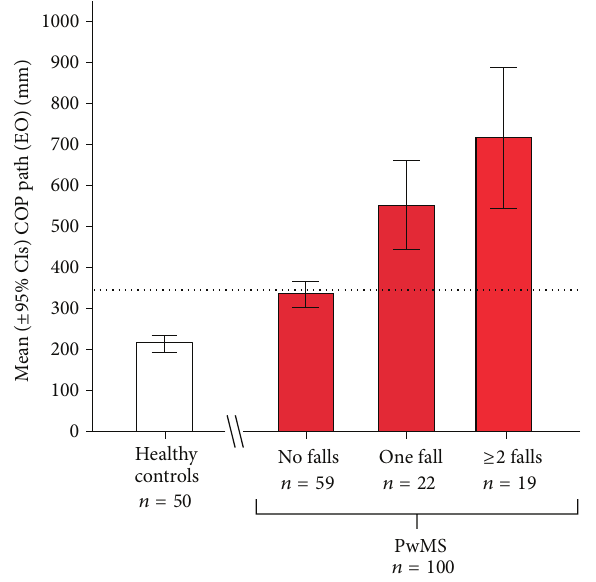
Figure 2: Mean ( ± 95% confidence intervals) values of centre of pressure (COP) path with eyes opened (EO) of healthy volunteers ( n =50) and patients with MS ( n =100) who were divided according to the number of accidental falls (0, 1, ≥ 2) prospectively collected over a 3-month follow-up period (modified from